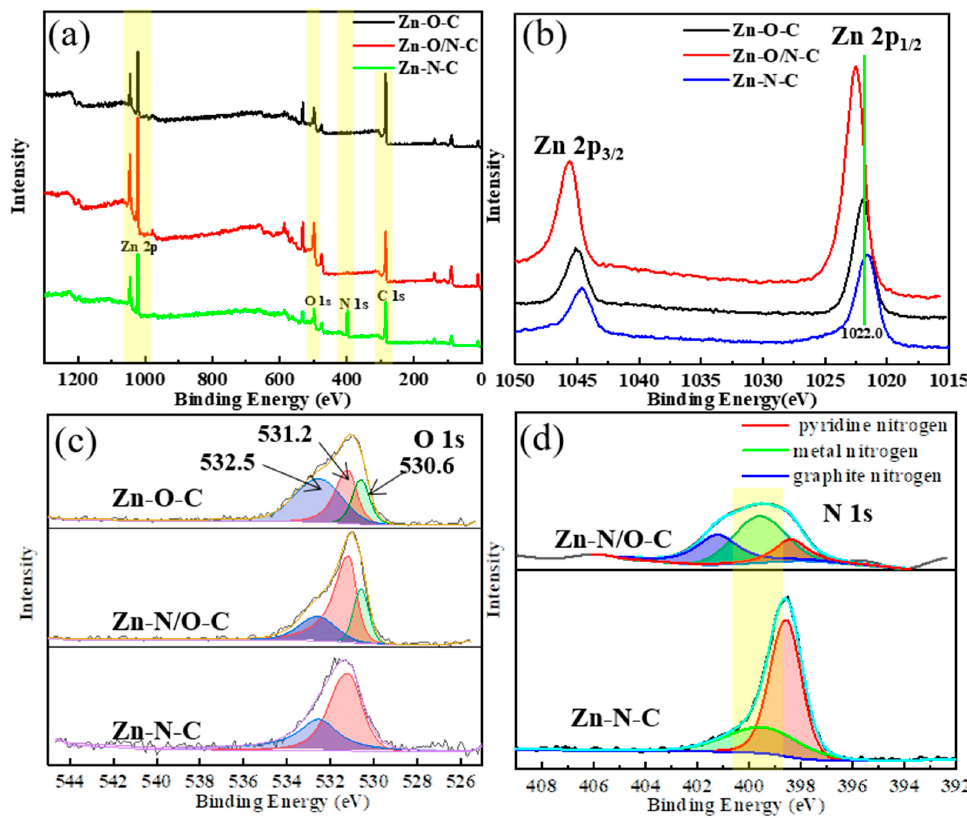
Figure 5. XPS pattern ( a ) and high-resolution XPS spectra of Zn 2p ( b ), O 1s ( c ), and N 1s ( d ) of Zn-O-C, Zn-O/N-C, and Zn-N-C.